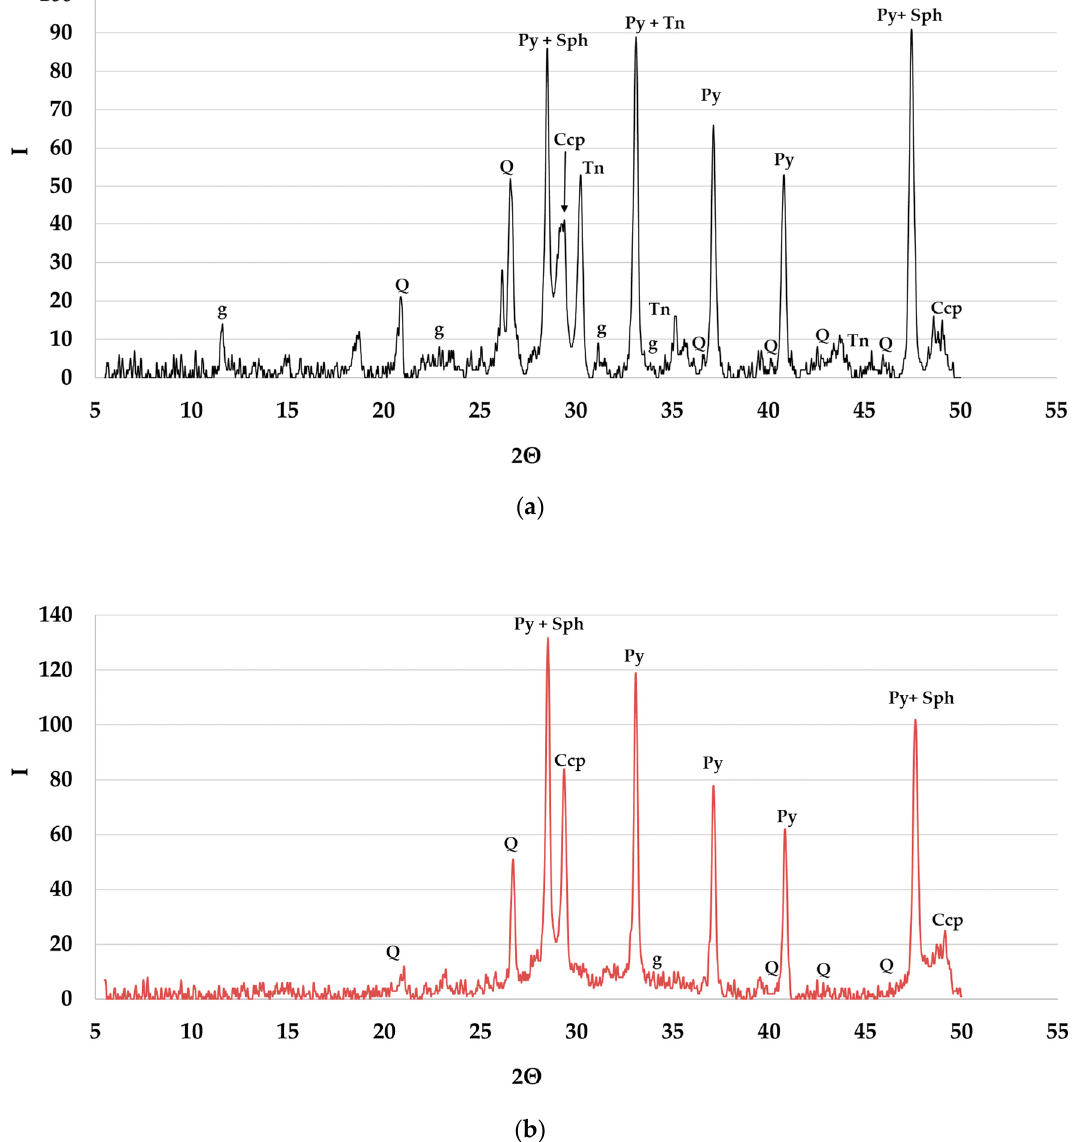
Figure 1. X-ray diffraction pattern of the samples: ( a ) concentrate, ( b ) sulfide leaching residue. Py: pyrite; Sph: sphalerite; Tn: tennantite; Ccp: chalcopyrite; g: gypsum; Q: quartz.